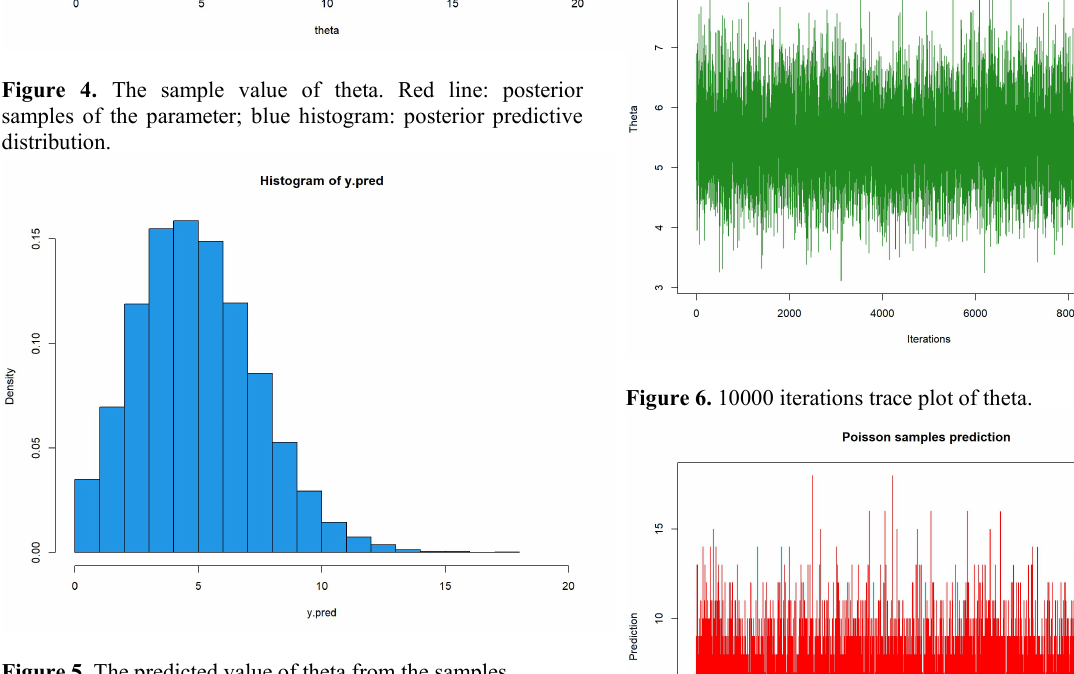
Figure 5. The predicted value of theta from the samples.